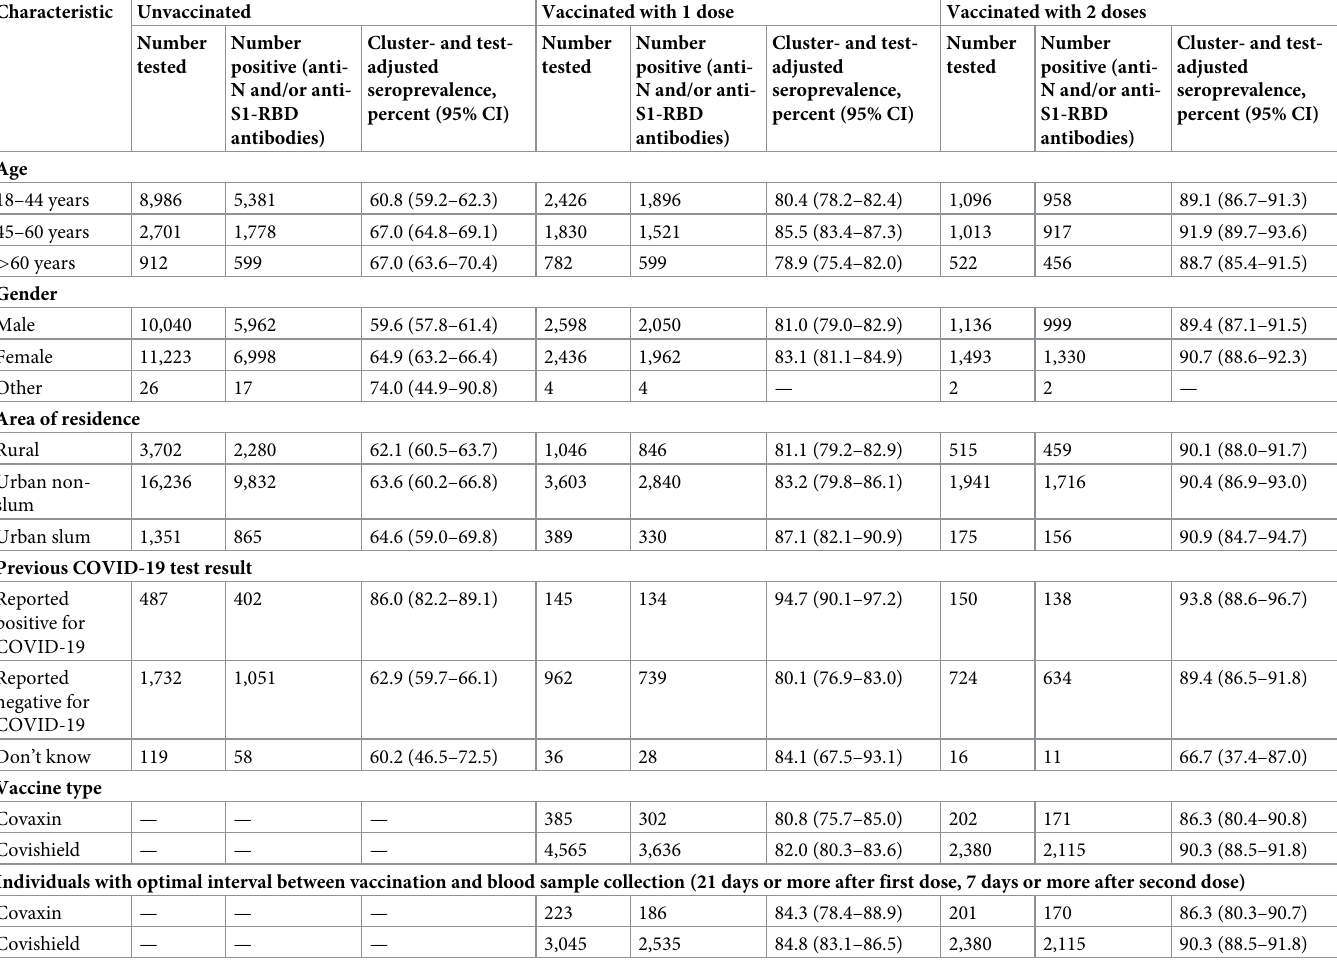
Table 4. Seroprevalence of IgG antibodies against SARS-CoV-2 in the general population by vaccination status, June–July 2021. Characteristic